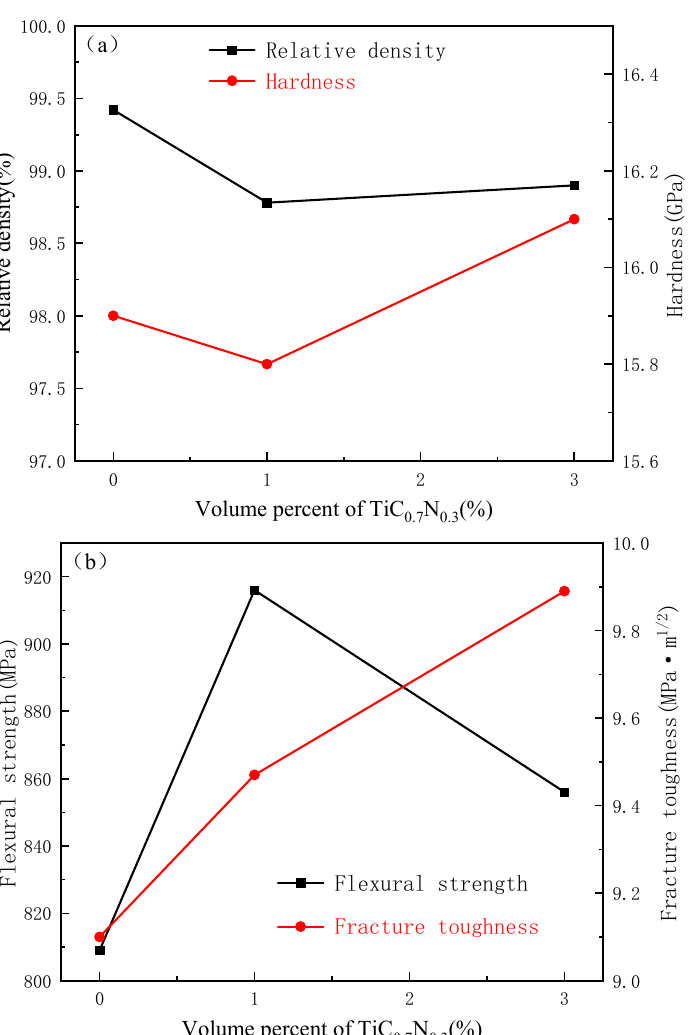
Figure 3. The effect of different volume fractions of TiC 0.7 N 0.3 in SN1, SN2, and SN3 on the properties: ( a ) Relative density and Vickers hardness; ( b ) Flexural strength and fracture toughness. Figure 4 is the backscattered photos of the polished surface of the sample without and Table 2. Effect of TiC 0.7 N 0.3 content on the mechanical properties of materials. with 1 vol% and 3 vol% TiC 0.7 N 0.3 added. It can be seen in Figure 4a–c that the black parts are distributed in stripes of different sizes, and the white areas are evenly distributed. With the increase of TiC 0.7 N 0.3 addition, the size of the black strips gradually decreased. The uniform distribution of the black and white areas indicates that the powders are well-mixed and have no serious agglomeration. Figure 5a,b is the energy spectrum (EDS) analysis